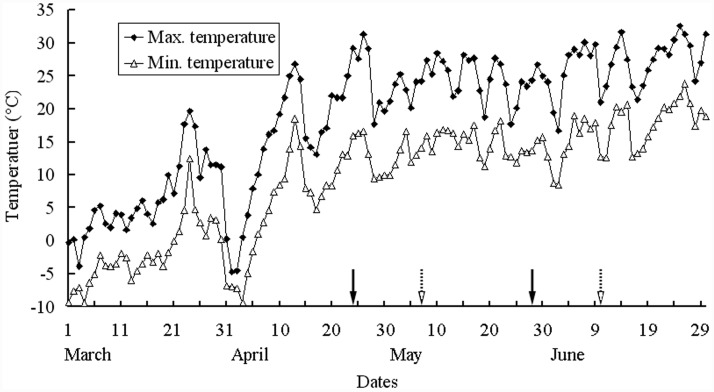
Mean maximum and minimum temperatures from March to June 2015 in Urümqi, China. Arrows with solid and broken lines are the periods from flowering to silicle maturation for proximal and distal positions on racemes of Isatis violascens, respectively. The weather data were provided by Geographical Information Monitoring Cloud Platform.